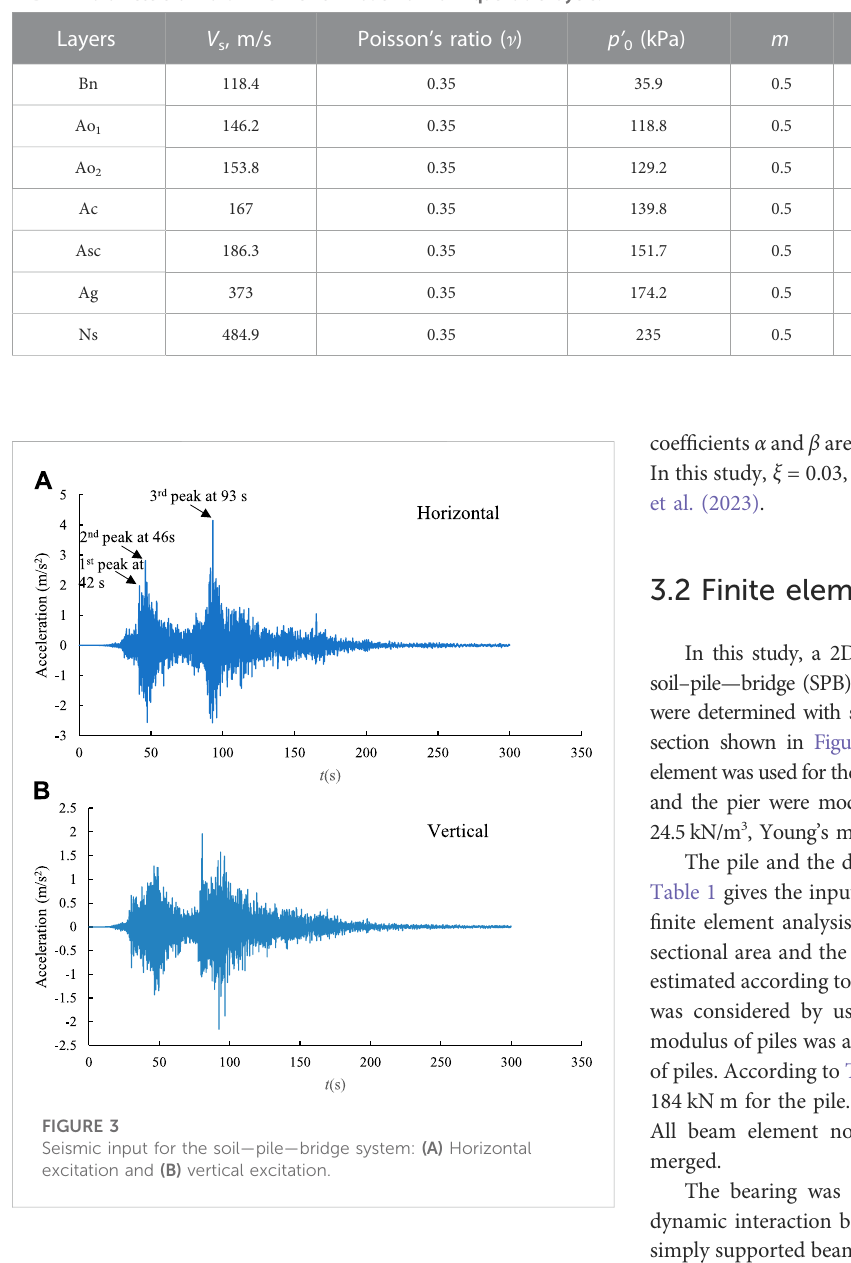
TABLE 4 Parameters of Hardin — Drnevich model for non-lique fi able layers.